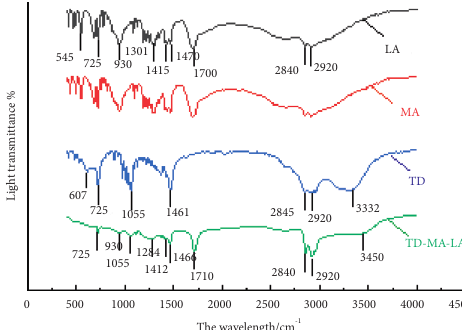
Figure 10: Infrared spectra of La, Ma, Td, and TD-MA-La com- posite phase change materials/.